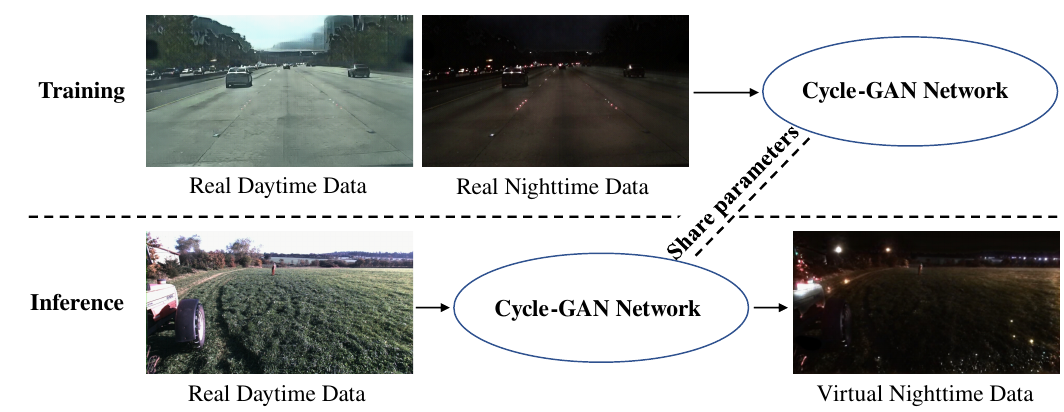
Figure 3. The training and inferring phase of Cycle-GAN. The network is trained with daytime and nighttime images from BDD100K [39], and utilize the trained network to generate virtual nighttime images.